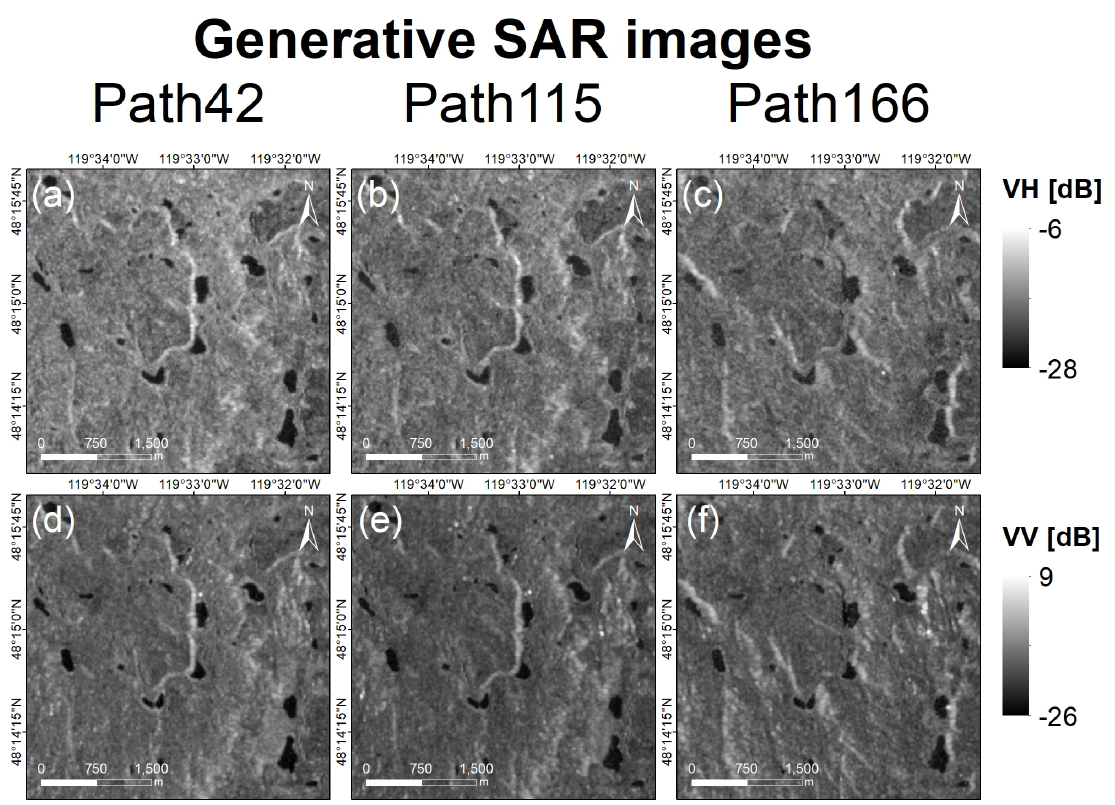
Figure 11. Examples of generative SAR images (VH polarization): ( a ) SAR image taken from Path42 on 22 July 2018. The average intensity of the image is − 20.63dB. ( b ) SAR image taken from Path 115 on 22 July 2018. The average intensity of the image is − 19.26dB. ( c ) SAR image taken from Path166 on 22 July 2018. The average intensity of the image is − 19.19dB. Examples of generative SAR images (VV polarization): ( d ) SAR image taken from Path42 on 22 July 2018. The average intensity of the image is − 13.31dB. ( e ) SAR image taken from Path 115 on 22 July 2018. The average intensity of the image is − 12.15dB. ( f ) SAR image taken from Path166 on 22 July 2018. The average intensity of the image is − 12.12dB.